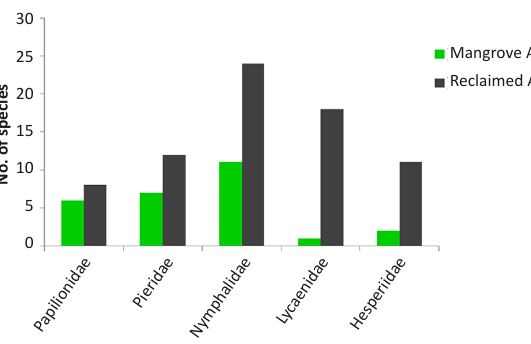
Figure 5. Butterfly families compared among mangrove and reclaimed areas in Indian Sundarbans in terms of their species richness.